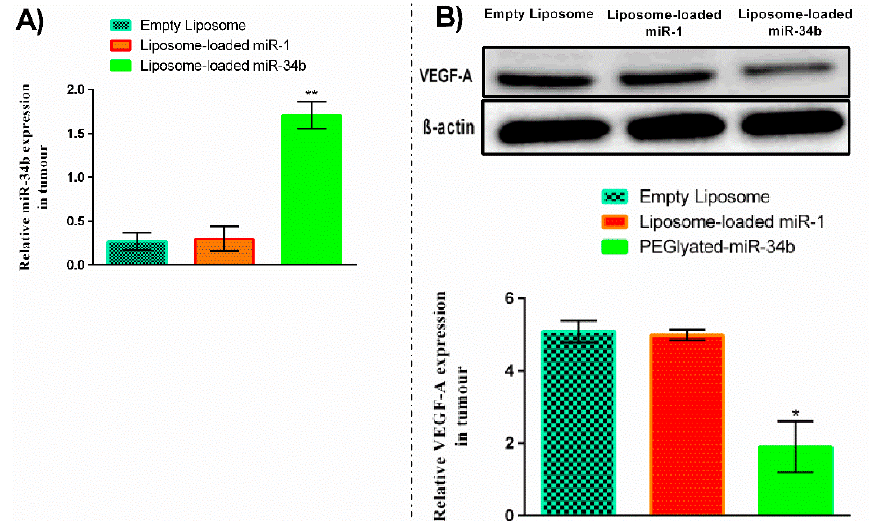
Figure 7. Liposome-loaded miR-34b increases the expression level of miR-34b and decreases VEGF-A protein expression level in xenograft nude mouse tumour. ( A ) Relative miR-34b expression after intravenous injection of liposome-loaded miR-34b, liposome-loaded miR-1 and empty liposome, detected by qRT-PCR ( n = 6). miR-34b expression level was significantly increased after intravenous injection of liposome-loaded miR-34b in mice when compared to mice injected with liposome-loaded miR-1 and empty liposome. ( B ) VEGF-A protein expression level also was significantly decreased after intravenous injection of liposome-loaded miR-34b in xenograft nude mouse tumour when compared to mice receiving liposome-loaded miR-1 and empty liposome. Data are presented as mean ± SD with n = 6. Level of significance, * p < 0.05, ** p < 0.01 when compared to the control groups.